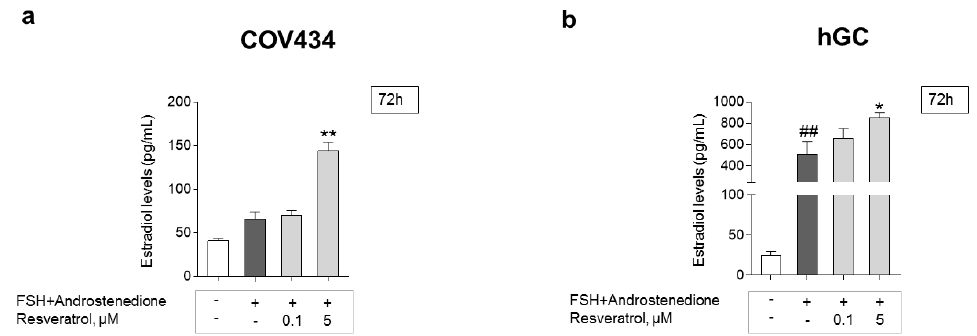
Figure 6. RES effect on the secretion of estradiol by GC. Impact of RES on estradiol secretion after 72 h on COV434 ( a ) and primary hGC ( b ); significant differences between cells treated with follicle-stimulating hormone (FSH) and 4-androstenedione and control are marked as ## ( p < 0.01). Significant differences between cells treated with different concentrations of RES and cells with only FSH and 4-androstenedione are marked as * ( p < 0.05), ** ( p < 0.01). For both cell models, results are expressed as mean ± SEM of at least three (maximum seven) independent experiments performed in triplicate.